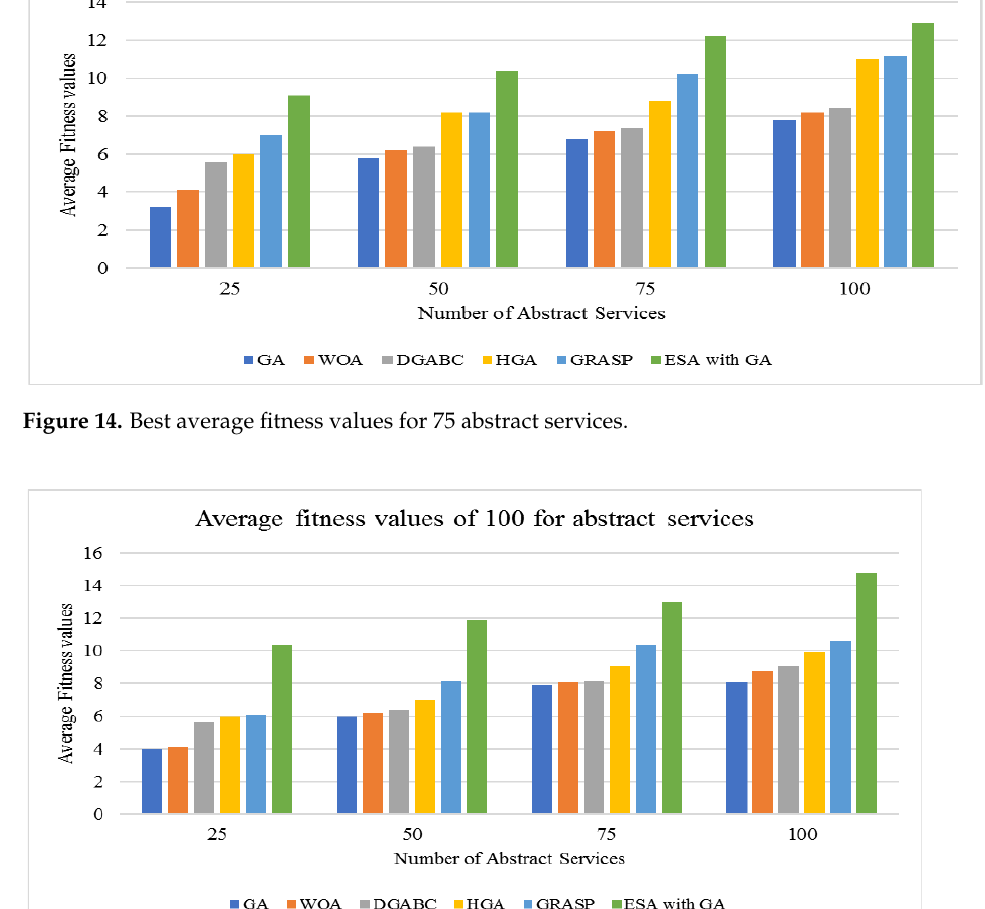
Figure 14. Best average fitness values for 75 abstract services.